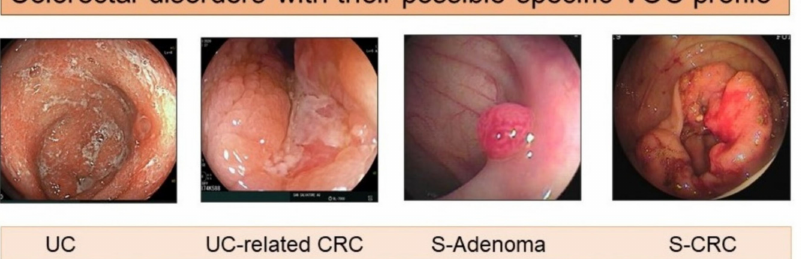
Figure 3. Increased evidence suggests that patients with inflammatory bowel disease (IBD), both ulcera- tive colitis (UC) and Crohn’s Disease (CD), IBD-related CRC, sporadic adenomas, or sporadic CRC may have their own specific VOC profile that could be used in their diagnosis and monitoring. It is not known whether VOCs have a pathogenetic role in colorectal carcinogenesis. S-adenoma = sporadic adenoma; S-CRC = sporadic colorectal cancer; VOCs = volatile organic